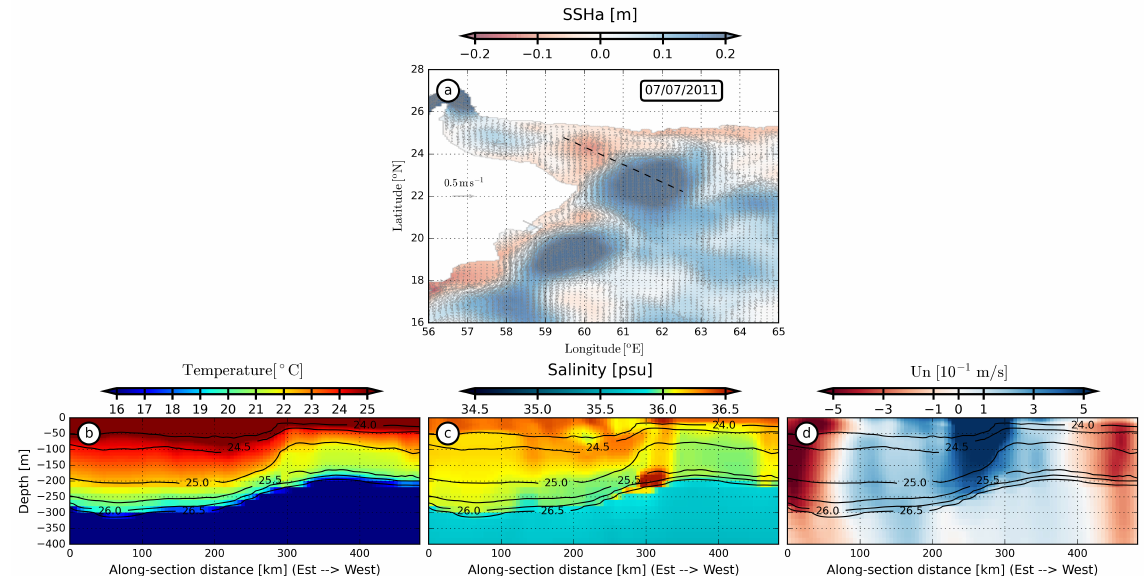
Figure 7. ( a ) Snapshot of the sea surface height (SSH) anomaly (HYCOM). The black dashed line represents the location of the vertical section. ( b – d ) Represent the temperature, salinity, and the cross-section velocity for the cyclone and anticyclone of the Ras al Hadd dipole, respectively. The black solid lines represent the